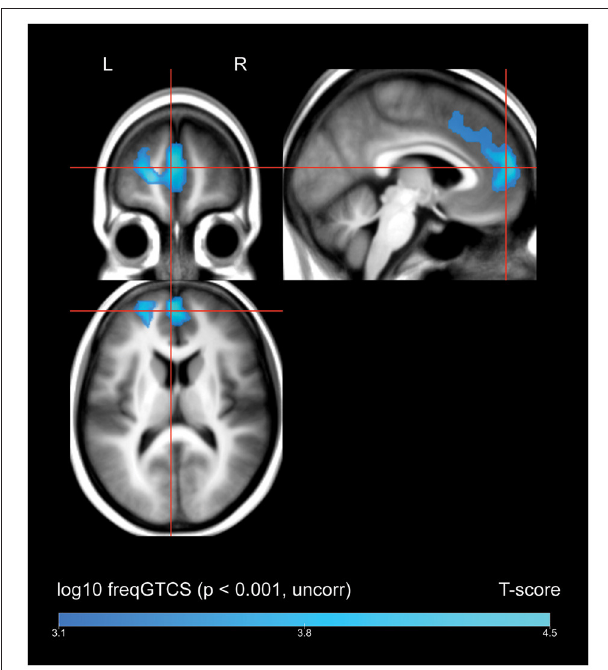
FIGURE 2 | Whole brain SPM results, regression of frequency of FBTCS against FDG-uptake. Displayed at peak height threshold T > 3.2 ( p < 0.001 uncorrected), with an extent threshold k = 110 voxels. Clusters smoothed for display purposes. Covariates included age, sex, weight, and summed intensities of high intensity voxels, ventricular voxels, and white matter voxels. Regions of where increasing frequency of FBTCS predicts decreased FDG-uptake are depicted in